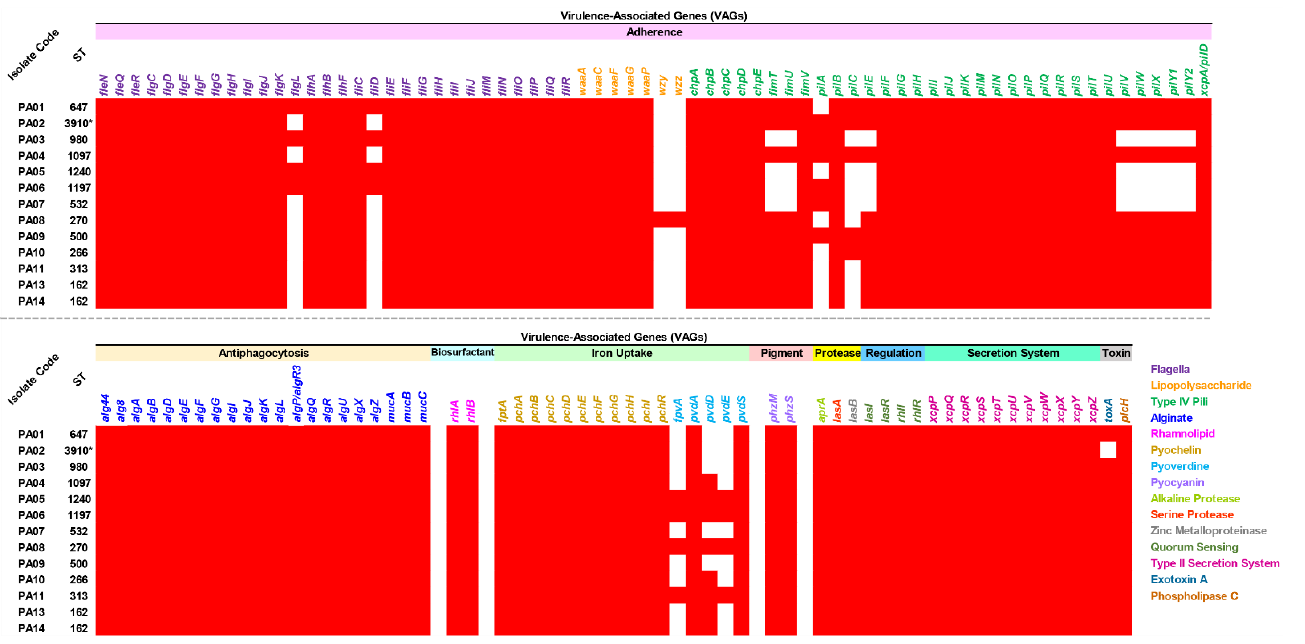
Figure 3. Distribution of virulence-associated genes (VAGs) in the colonizing isolates of P. aeru- ginosa . The red box represents the gene presence. ST, sequence type. * Novel ST.